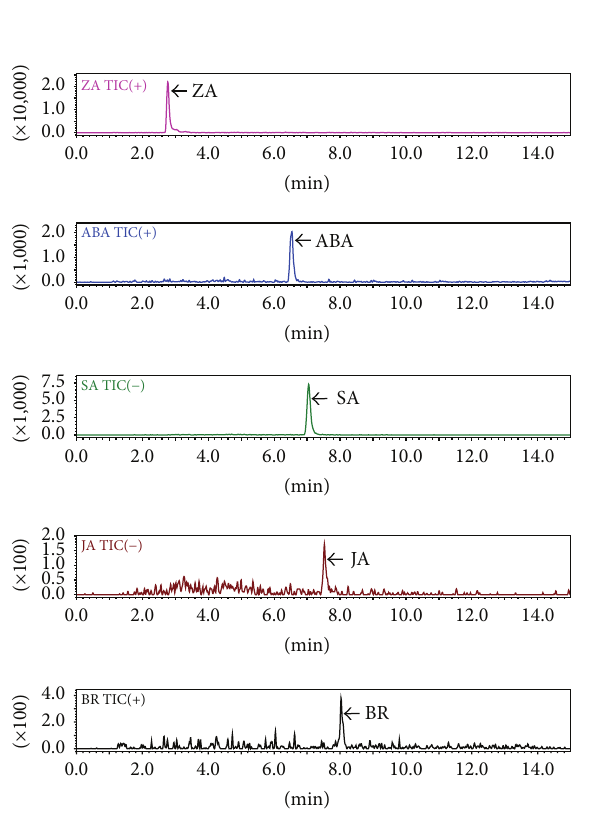
Figure 2: Typical MRM chromatograms of working solution of standard plant hormones [zeatin (ZA), abscisic acid (ABA), salicylic acid (SA), jasmonic acid (JA), and brassinolide